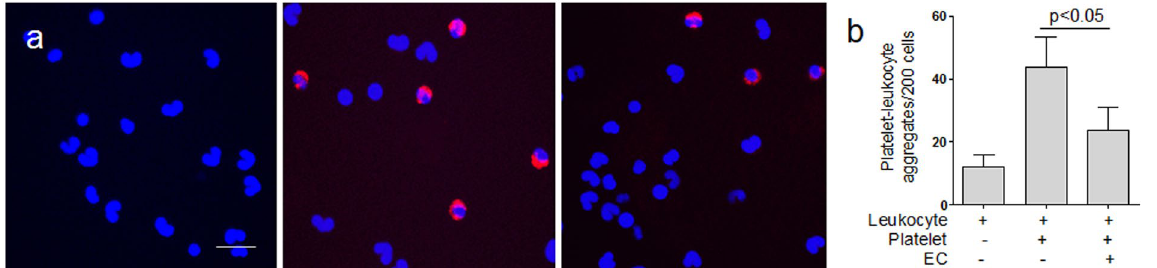
Figure 5. Platelet phagocytosis by ECs reduces PLA formation. ( a ) Platelets of patients (n = 15) were collected and labeled with Alexa Fluro 647-conjugated CD41a (red). Platelets before (middle) or after (right) engulfment by ECs were co-cultured with leukocytes (stained with DAPI, blue) from healthy subjects. Immunofluorescence showed that PLA formation was decreased after platelet phagocytosis by ECs. Untreated leukocytes from healthy individuals were used as control (left). Bars represent 20 μ m. ( b ) The number of PLA was counted under immunofluorescence before and after platelets were incubated with ECs. The number of PLA in untreated leukocytes from healthy individuals was used as control. Data represents mean ± SD.